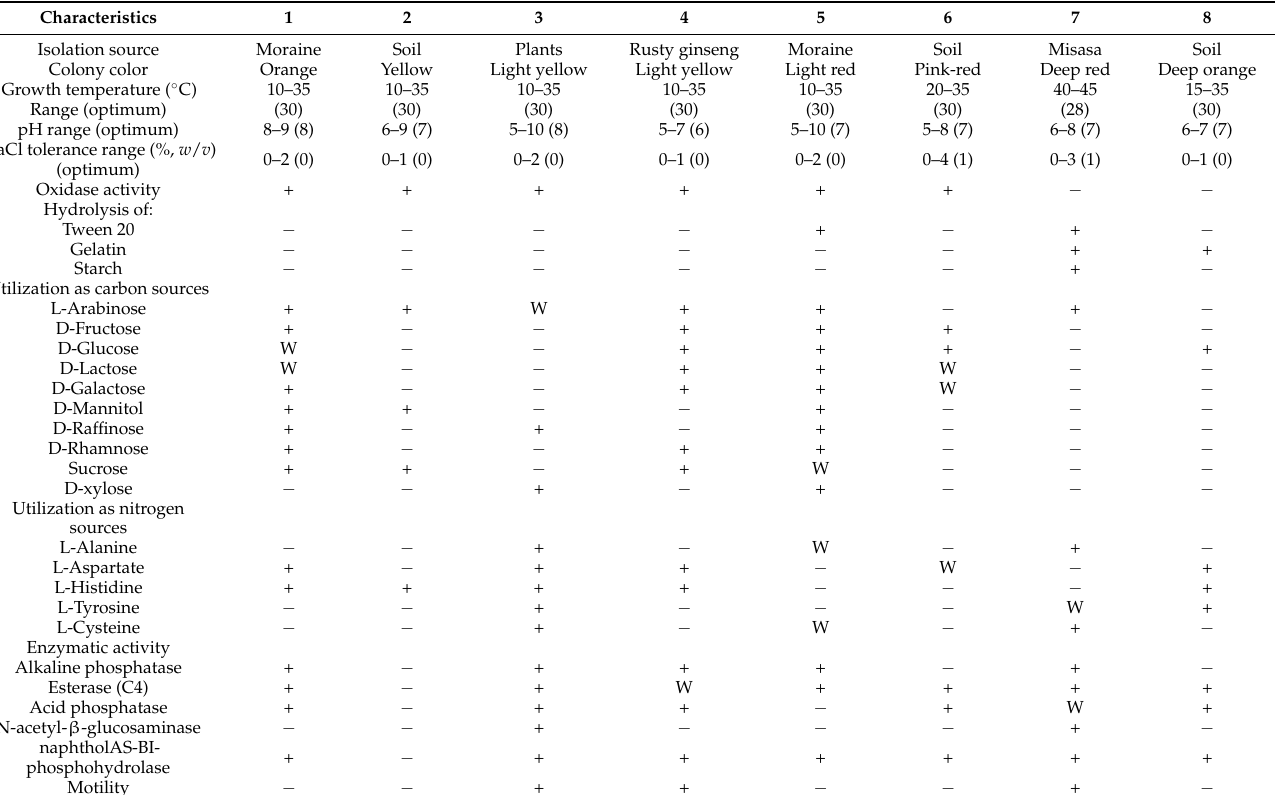
Table 1. Phenotypic characteristics of strain S5-59 T , strain S8-45 T , and their closely related type strains in the genus Sphingomonas